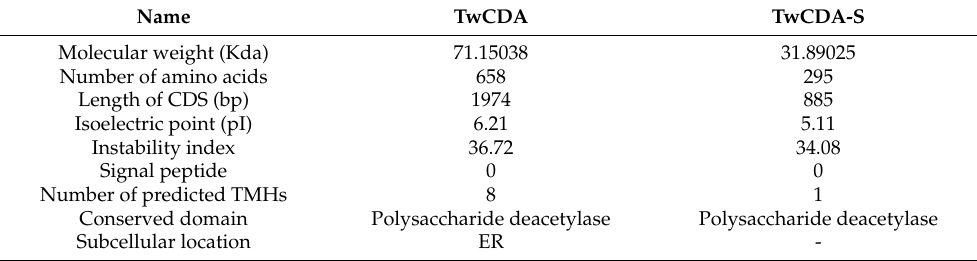
Table 1. Comparisons of TwCDA and TwCDA-S in terms of gene/protein structure, subcellular localization, and activities. CDS, coding sequences; ER, endoplasmic